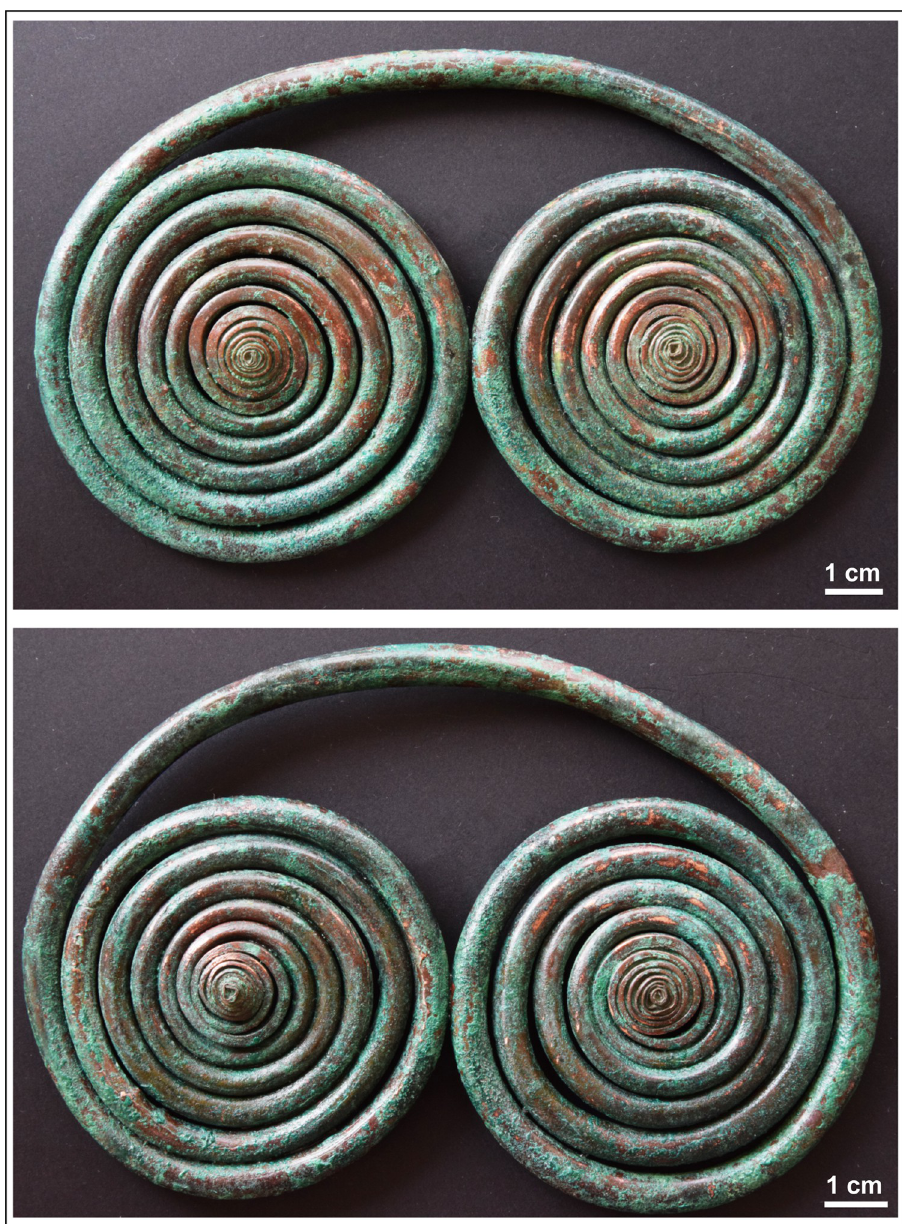
Fig 8. Spectacle spiral pendants. Photo: Pe´ter